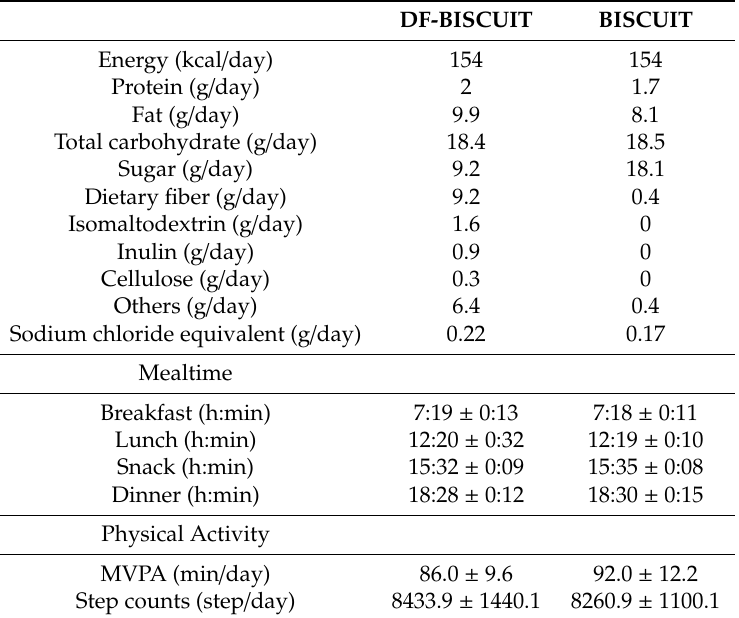
Table 1. Snack contents, mealtimes, and physical activity levels in both trials.